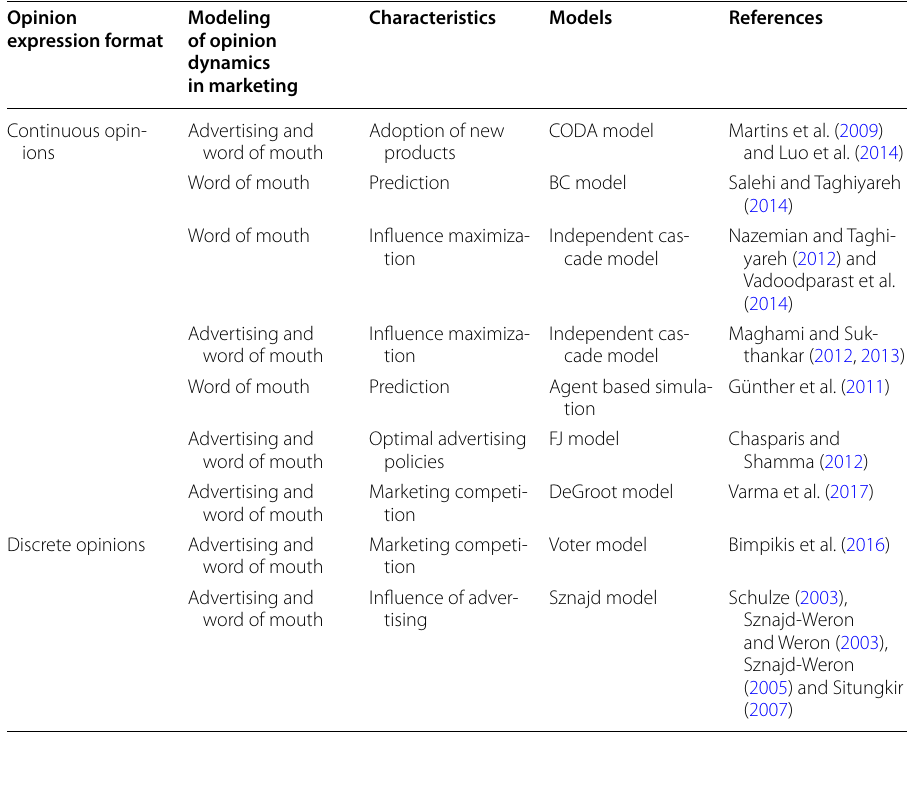
Table 2 The applications of opinion dynamics in marketing Opinion Modeling expression format of